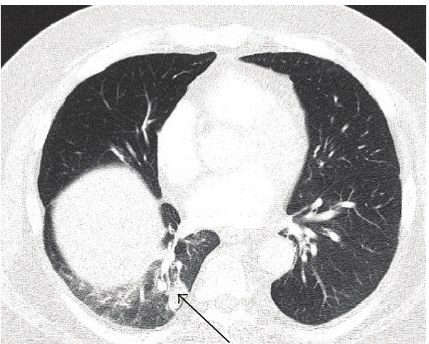
Figure 2: Axial image of CT of chest performed on January 31, 2014: pulmonary windows demonstrating a 2.3 cm nodular opacity in the right lower lobe (arrow) with minimal subsegmental atelectatic changes and ground-glass opacity.